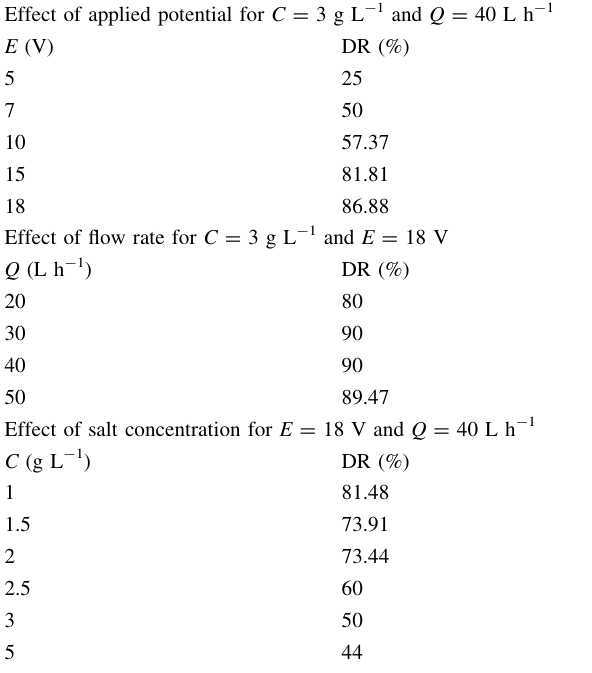
Table 7 Optimization of factors influencing the ED efficiency by the classical method optimization Effect of applied potential for C = 3 g L - 1 and Q = 40 L h - 1